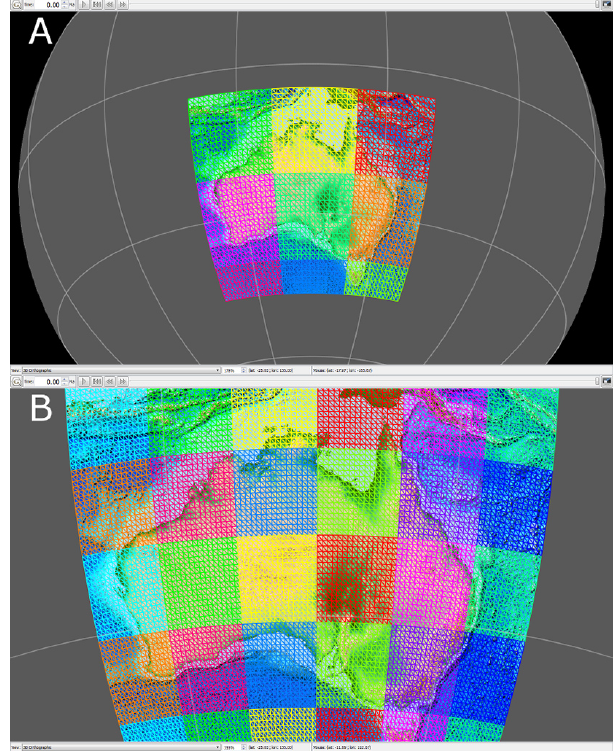
Figure 2. A regional (non-global) raster overlaid with colour-coded wireframe geo-reference tile meshes at two different tile resolutions (zoom levels). There are more tiles in (B) than in (A) , covering the same geographic region, because the next-higher resolution of the image pyramid (four times the pixels) is required for the zoomed-in view (B) compared to the zoomed-out view (A)